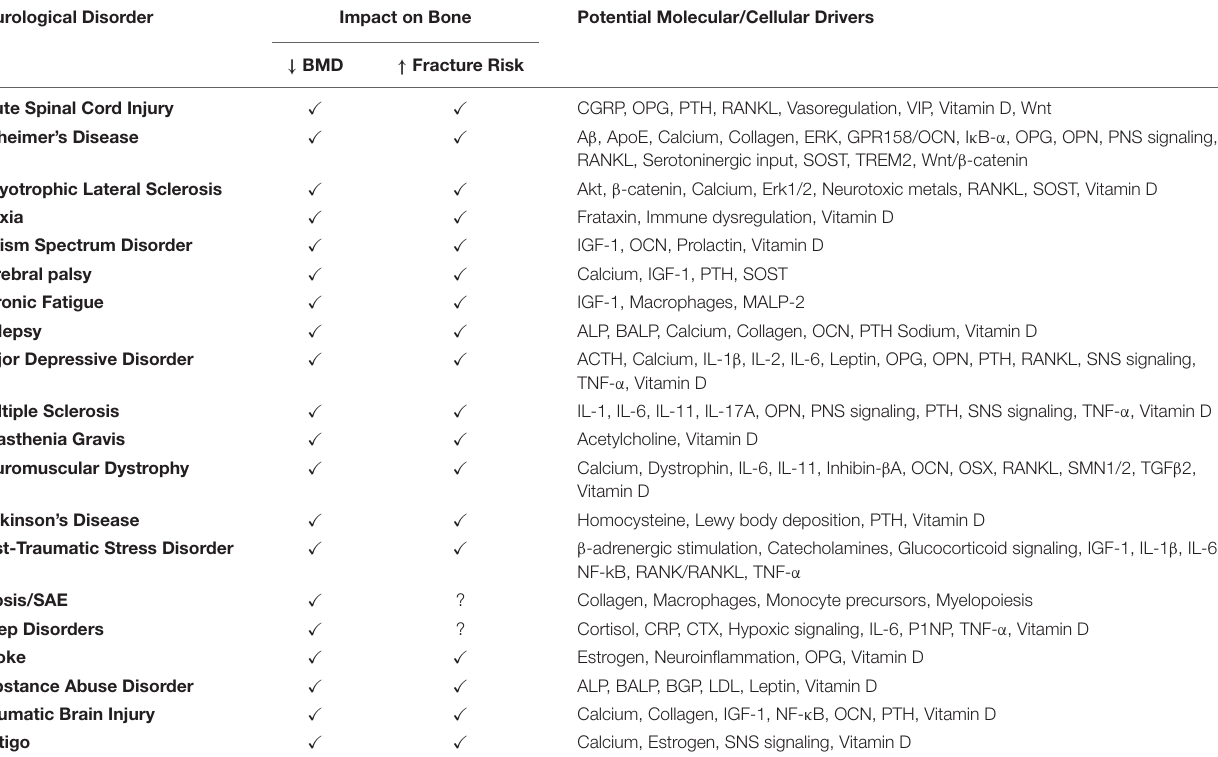
TABLE 1 | Neurological disorders, impacts on bone, and potential